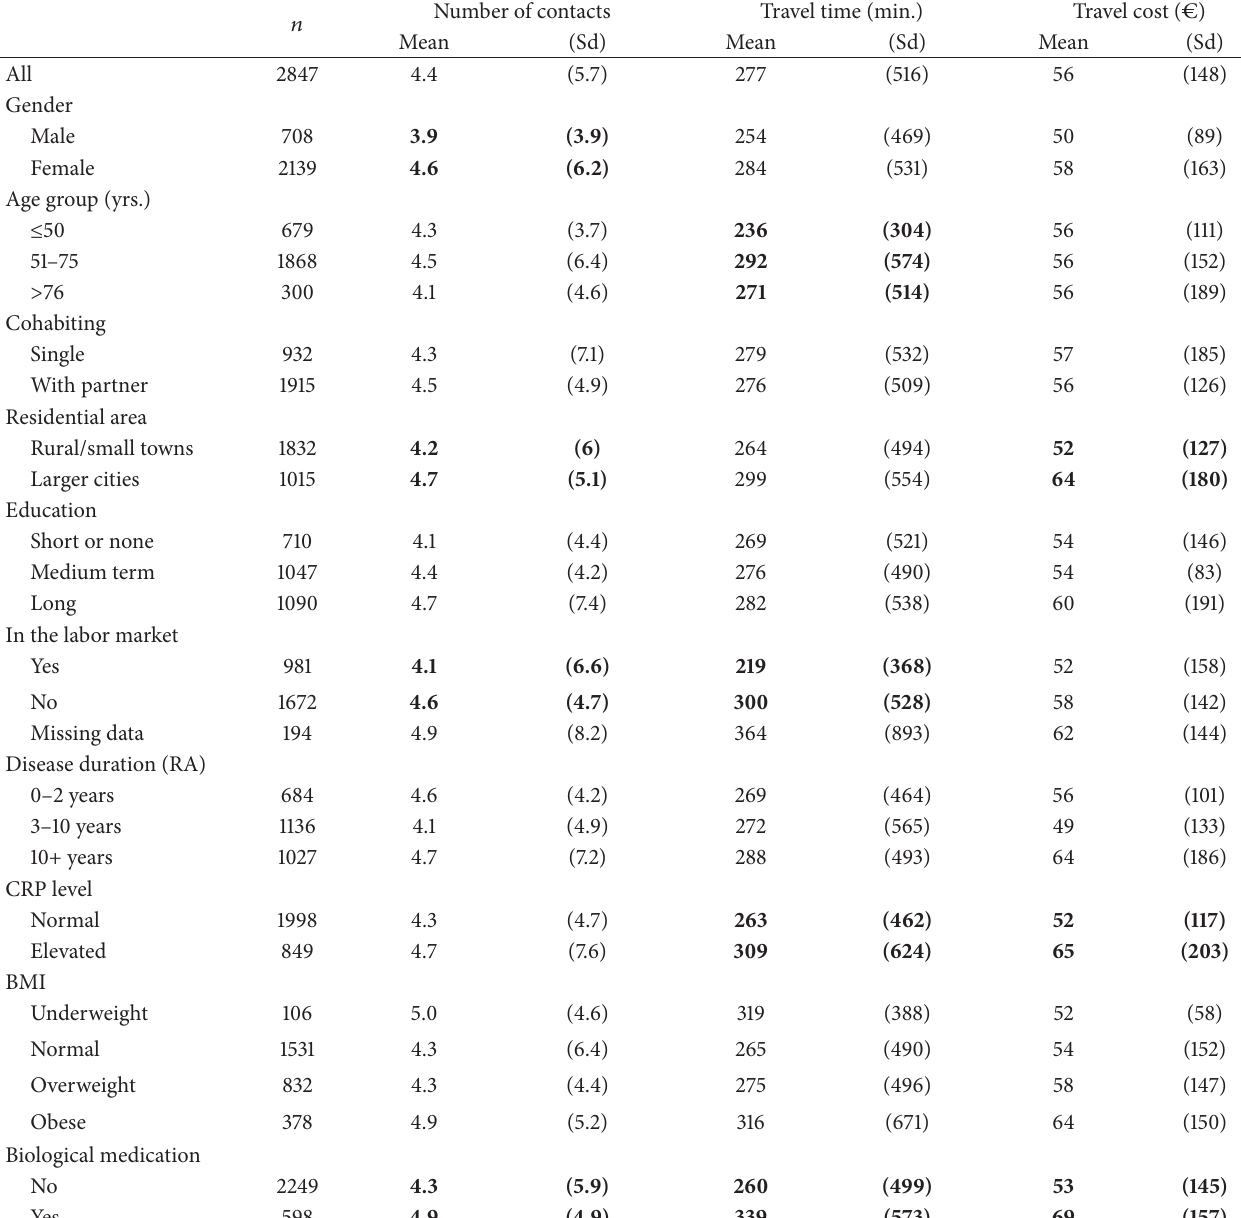
Table 4: Three-month average travel time and costs for patients with different